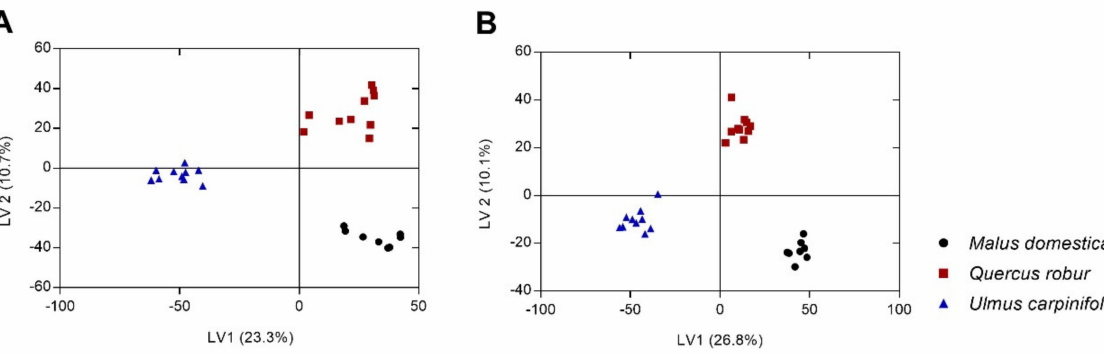
Figure 2. PLS-DA score plot for first and second latent variables showing the discrimination between V. album ssp. album from different host trees. Samples harvested in 2016 ( A ) and in 2017 ( B ). LV is latent